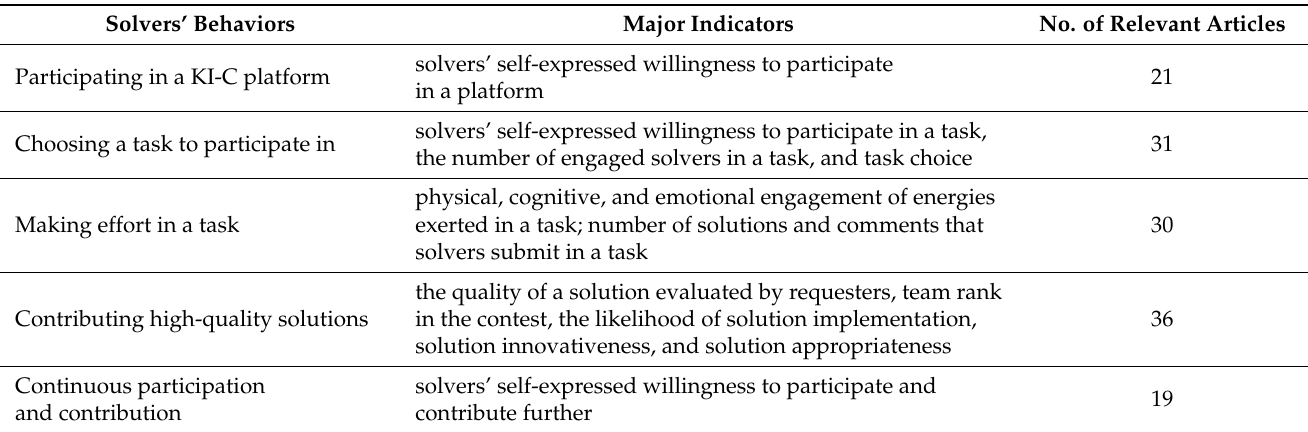
Table 2. Solvers’ participation behaviors and their